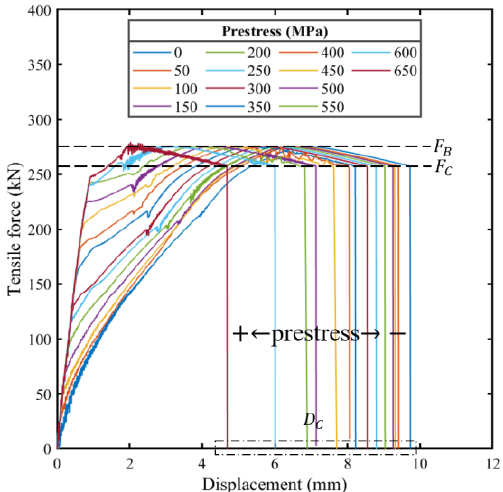
Figure 30. Response curves obtained from numerical simulation under different prestress.